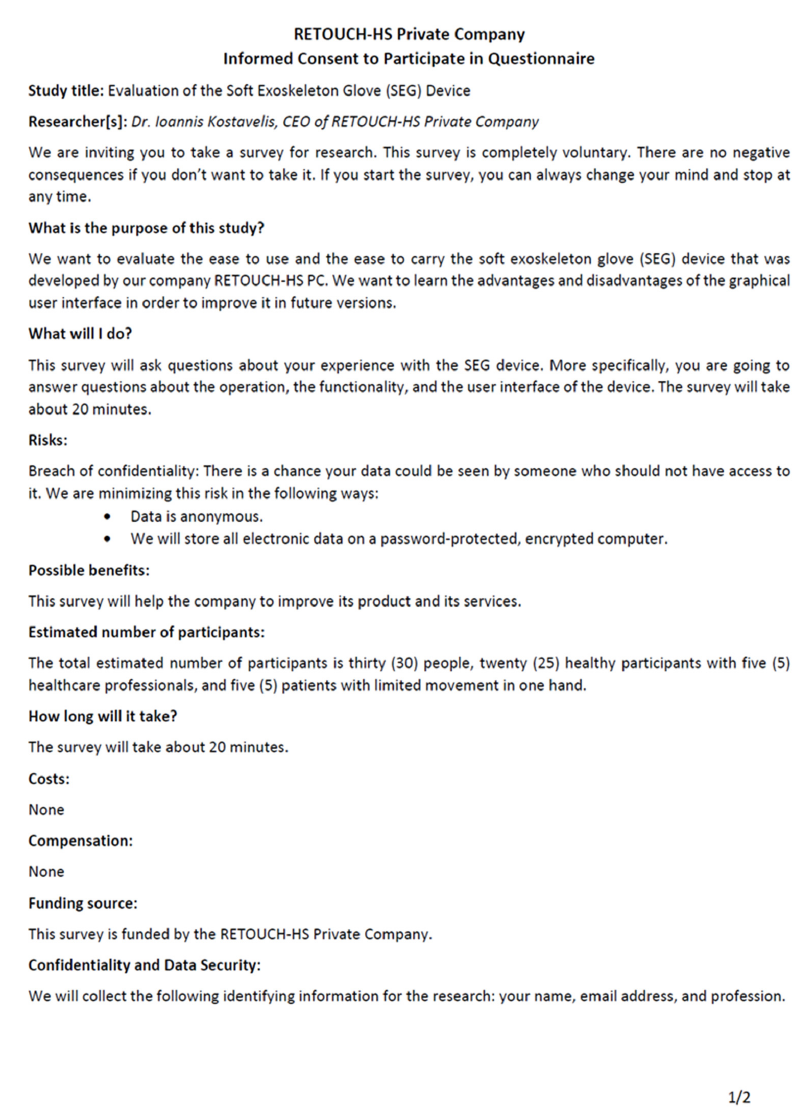
Figure A1. The first page of the informed consent form.